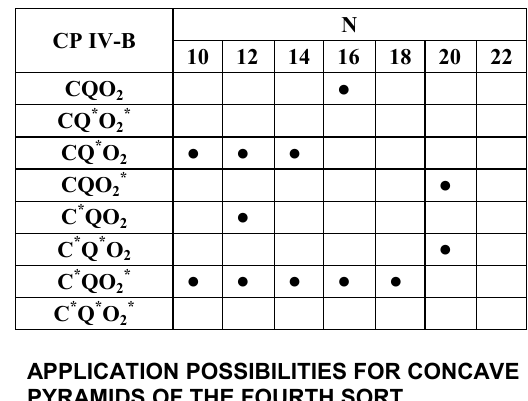
Table 3. Concave pyramids of the fourth sort – the possibilities of their generation above different polygonal base by applying disparate construction